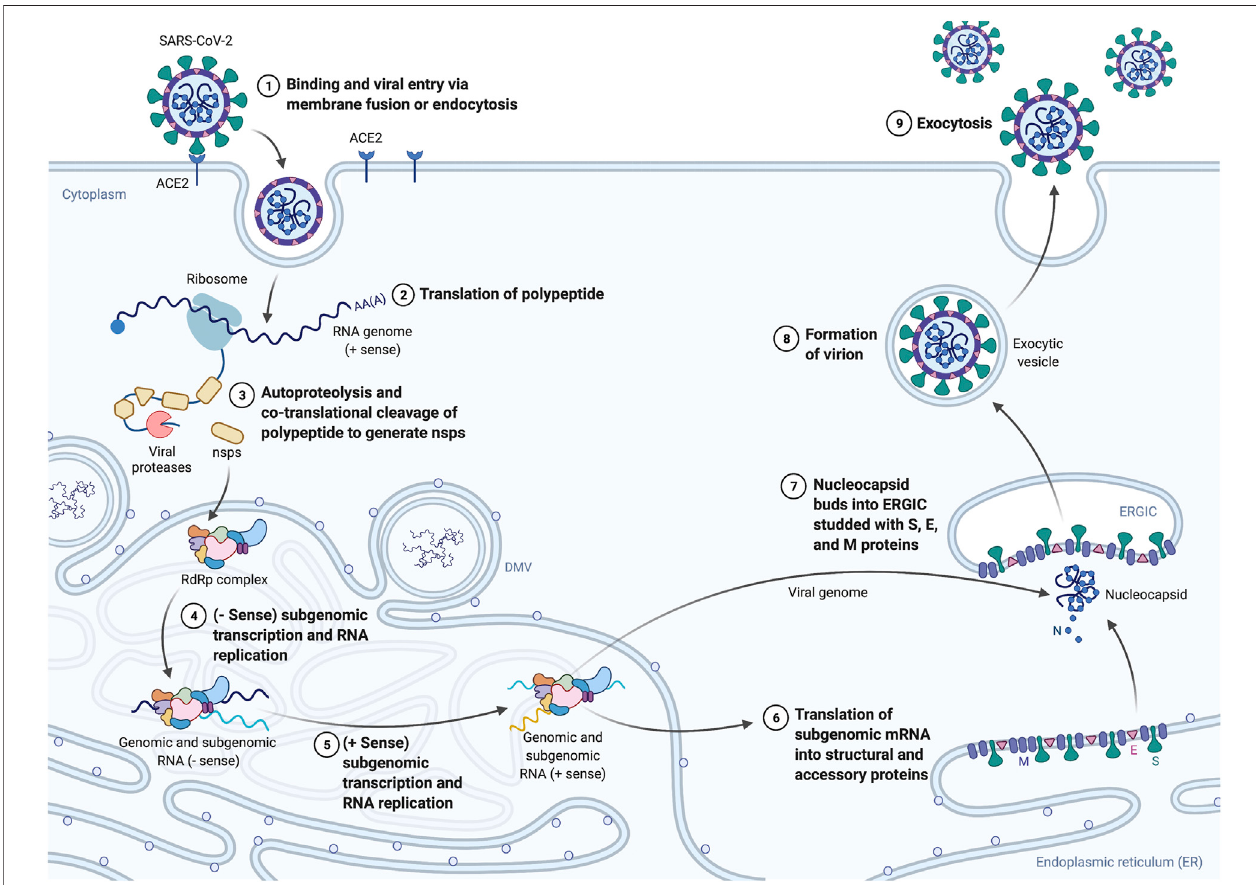
FIGURE 1 | (A) Schematic representation of the SARS-CoV-2 biogenesis. SARS-CoV-2 enters host cells interacting with the angiotensin-converting enzyme 2 (ACE2) receptor by the surface spike (S) protein. Upon entry of the virus into the host cell, viral genomic RNA is released into the cytoplasm, where it is translated into viral polymerase proteins. Here, sub-genomic ( – ) RNAs are synthesized and used as templates for sub-genomic (+) messenger RNAs (mRNAs). The nucleocapsid (N) structural protein and viral RNA are replicated, transcribed, and synthesized in the cytoplasm. In contrast, other viral structural proteins, including the S protein, membrane (M) protein, and envelope (E) protein, are transcribed and then translated in the endoplasmic reticulum (ER). The structural proteins traverse the ER-Golgi intermediate compartment for virion assembly, followed by the release of the nascent virion from the host cell via exocytosis. (B) Schematic representation of SARS-CoV-2 sgRNA synthesis. SARS CoV-2 sgRNAs are synthesized via discontinuous transcription. Beginning from the 3 ′ end of the genomic RNA, RdRp transcribes the body and is halted at the transcription-regulatory sequence in the body (TRS-B). RdRp then resumes transcription at the TRS-L (transcription-regulatory sequence at the leader sequence), a more 5 ′ location on the genomic RNA. Next, the newly generated negative strand is used as a template for positive-strand synthesis. The TRS is located next to ORFs. Therefore, the positive sense mRNA (sgRNA) produced from the negative-sense RNA contains the leader-sequence fused to the distal ORF. Created with BioRender.